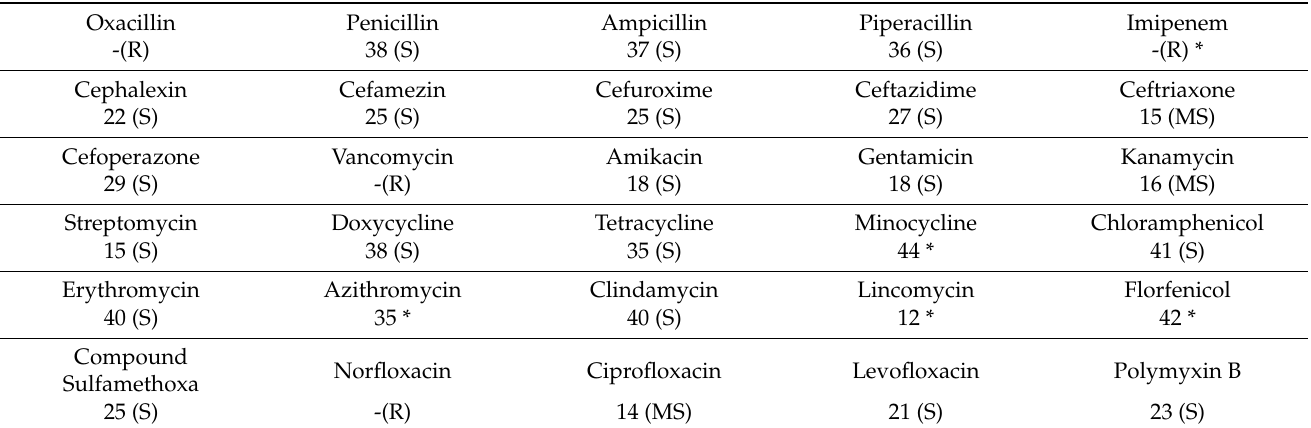
Table 2. Inhibition zone diameter (mm) and susceptibility results of antibiotics against Loigolactobacil- lus coryniformis